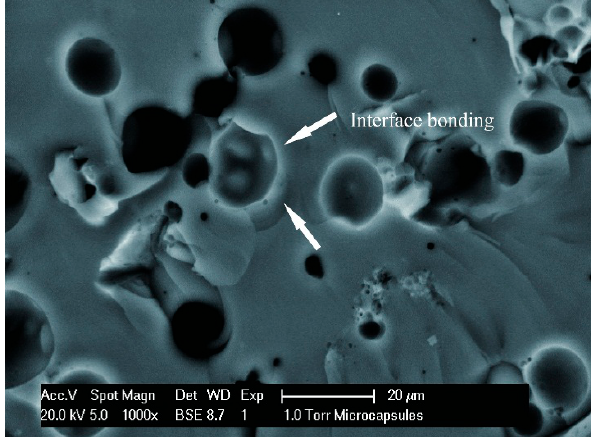
Figure 5. SEM cross-section morphology of a microcapsules/bitumen sample. Table 1. The microcapsule/bitumen samples with various microcapsules.